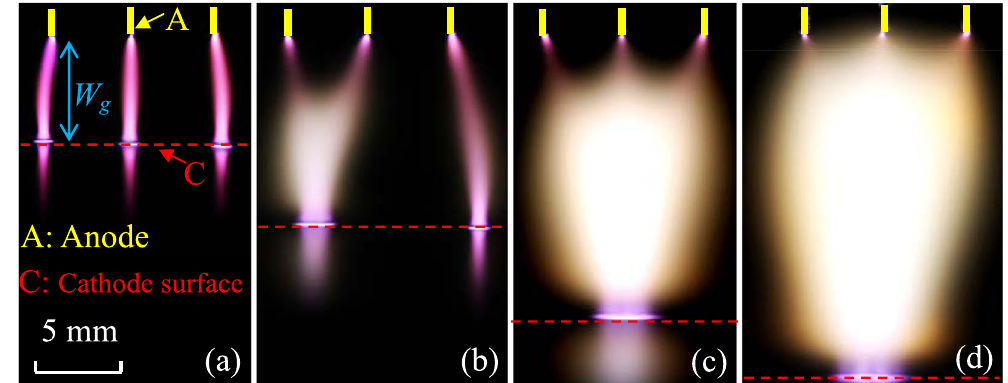
Figure 2. Discharge images under different gap widths: ( a ) 6 mm, ( b ) 11 mm, ( c ) 17 mm, ( d ) 20 mm. The exposure time is 125